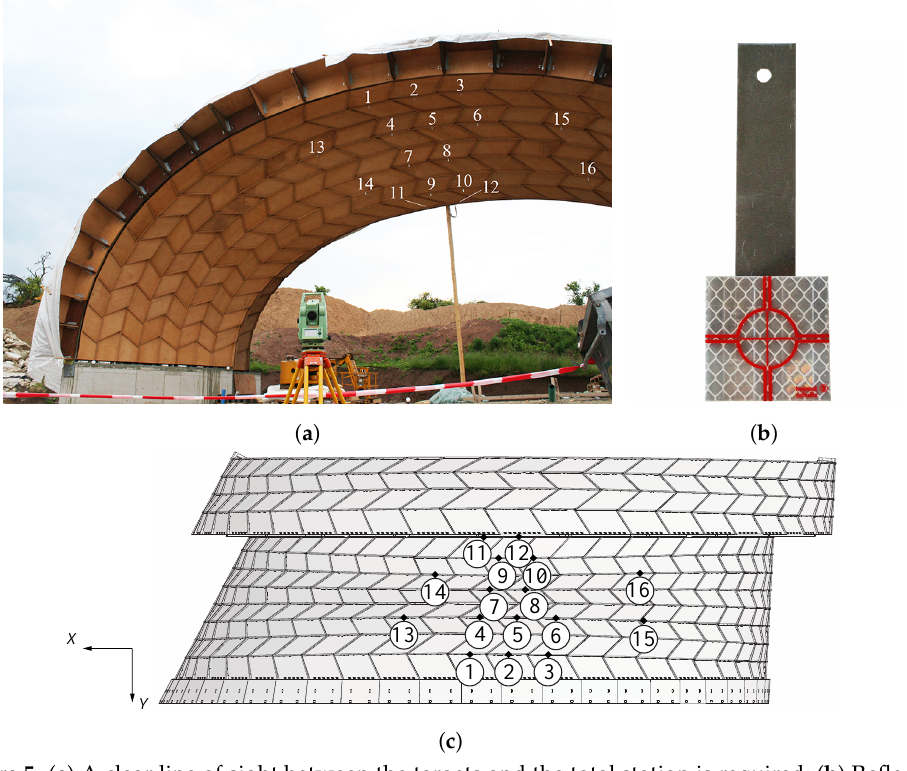
Figure 5. ( a ) A clear line of sight between the targets and the total station is required; ( b ) Reflective targets 3 × 3 cm; ( c ) Position of the 16 targets on arch n°